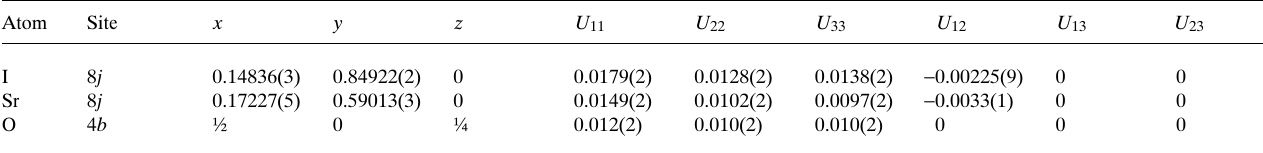
Table 2. Atomic coordinates and displacement parameters (in Å 2 ) .